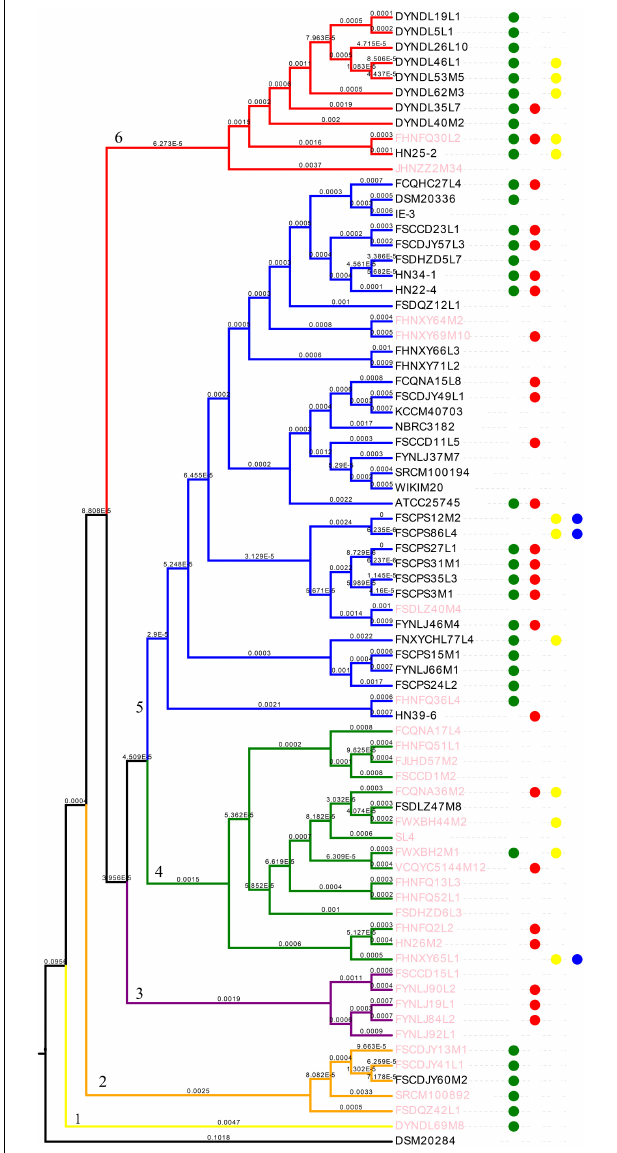
FIGURE 5 | Phylogenetic analysis of P. pentosaceus. Phylogenetic supertree showing the relationship among 74 P. pentosaceus strains with P. acidilactici DSM20284 as outgroup. The tree was grouped in to six clades signed by number 1–6. The dots represented strains that contained the operon of bacteriocins. In specific, red dots represented enterolysin A, green dots represented penocin, yellow dots pediocin, blue dots Bac. Pink font represented strains contained CRISPR/Cas type